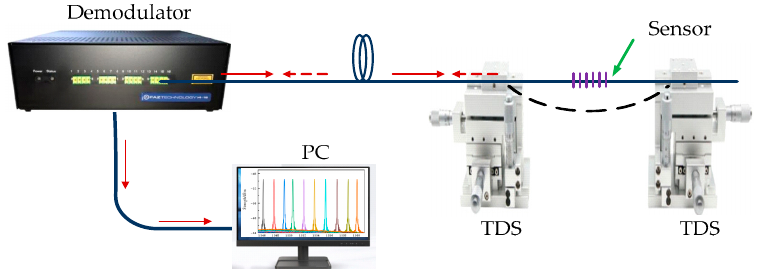
Figure 4. Bending experiment test device system.